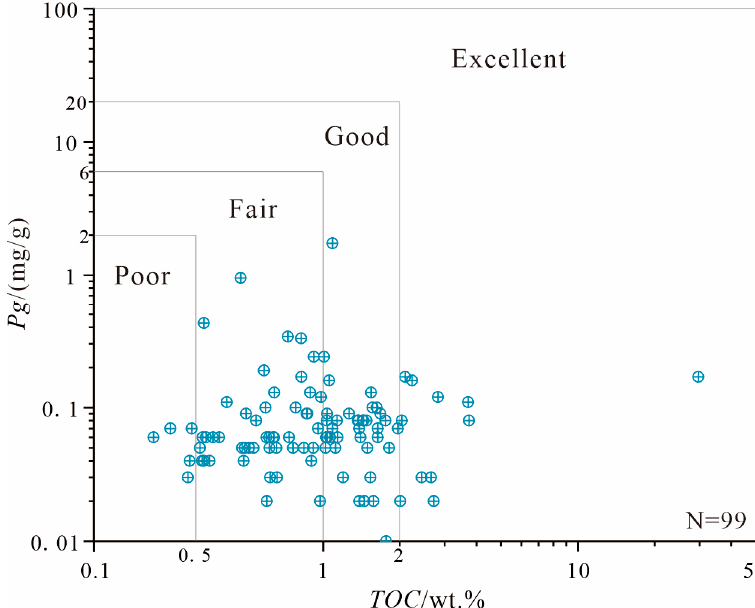
Figure 2. The cross-plot of Pg and TOC [37].